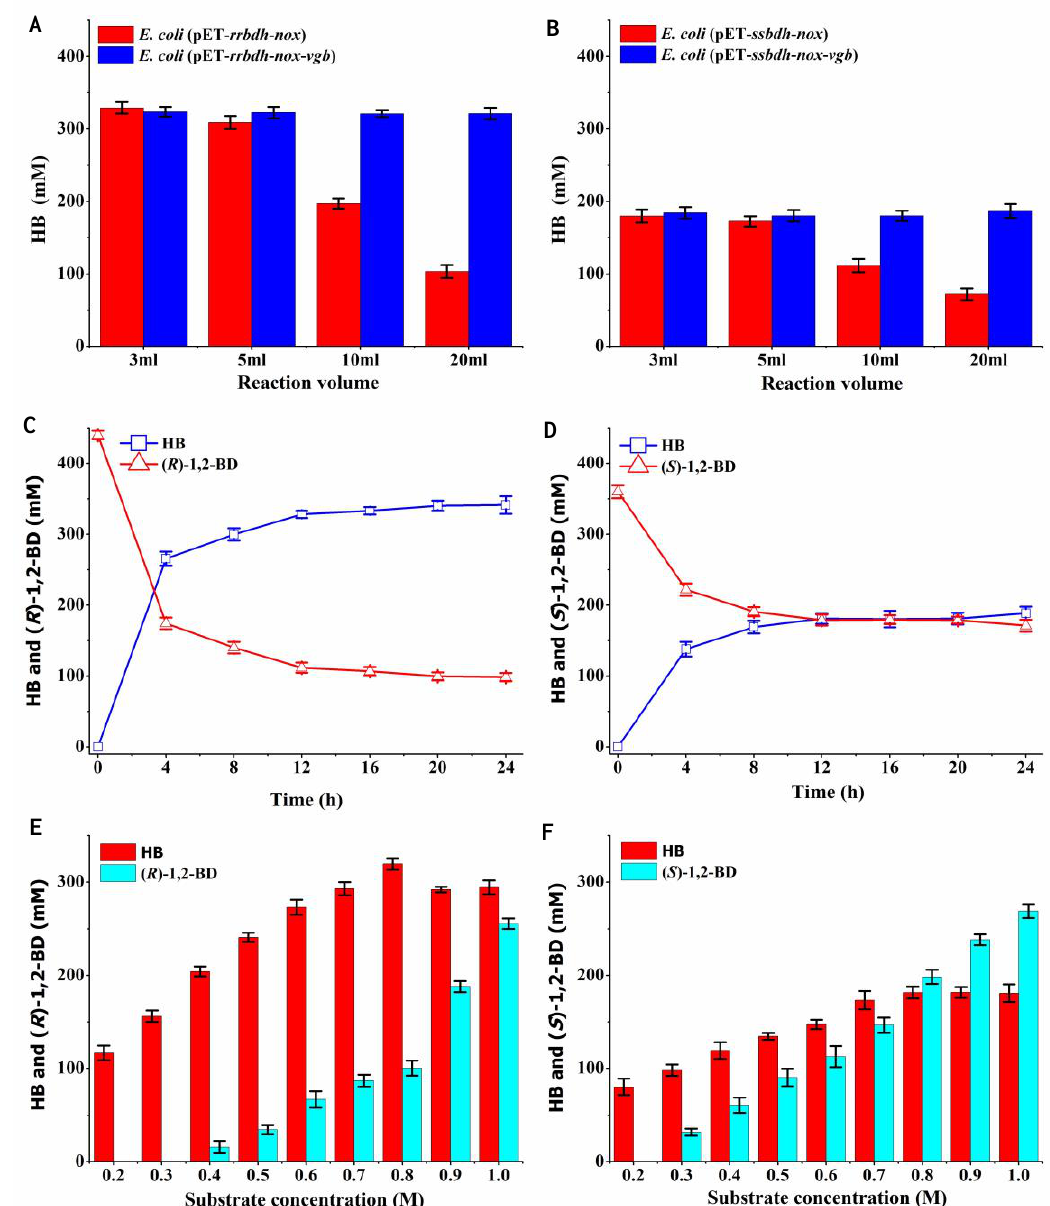
Figure 6. Effects of VHB co-expressed with with BDH and NOX in E. coli on HB production from 1,2-BD mixture by whole cell biocatalyst of E. coli (pET- rrbdh - nox - vgb ) and E. coli (pET- ssbdh - nox - vgb ). ( A , B ) Effects of VHB expression on HB production by E. coli (pET- rrbdh - nox - vgb ) and E. coli (pET- ssbdh - nox - vgb ) under different reaction volumes; ( C , D ) Time-course profiles of HB production from 1,2-BD mixture by E. coli (pET- rrbdh - nox - vgb ) and E. coli (pET- ssbdh - nox - vgb ); ( E , F ) Effects of different substrate concentrations on HB production by E. coli (pET- rrbdh - nox - vgb ) and E. coli (pET- ssbdh - nox - vgb